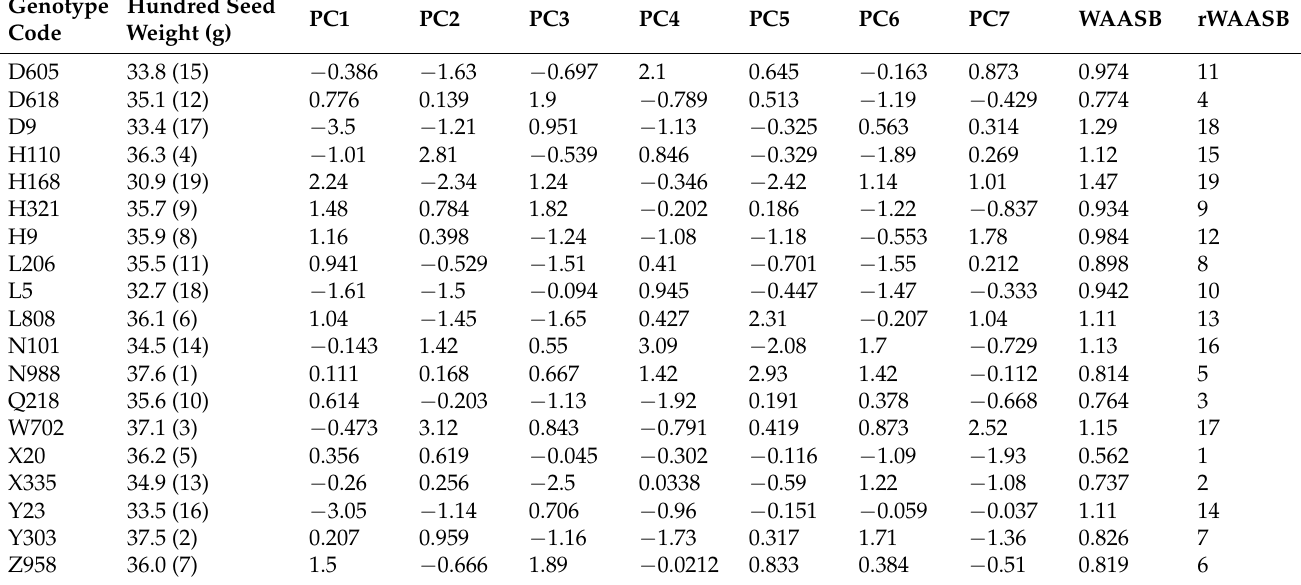
Table 6. The mean hundred seed weight and WAASB scores of evaluated